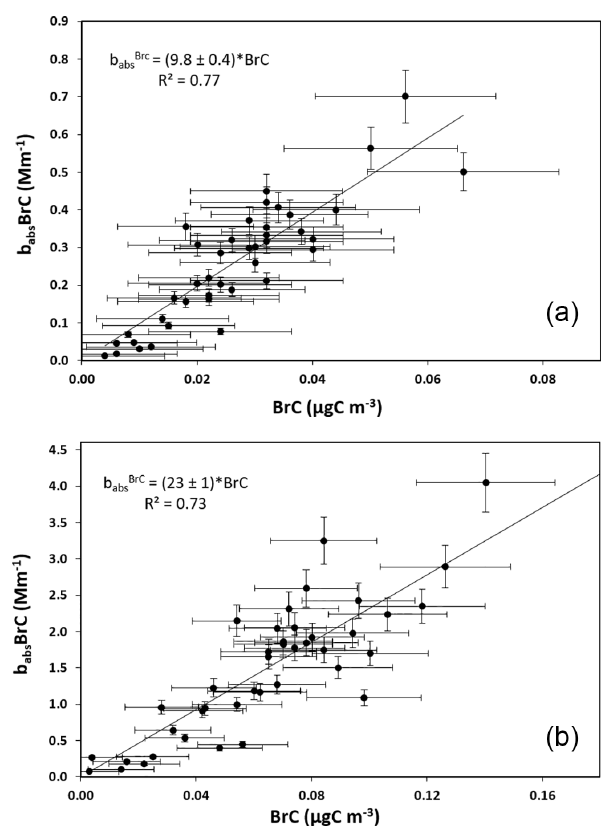
Figure 7. Comparison between the aerosol absorption coefficient apportioned to brown carbon vs. the resulting operative BrC con- centration values at λ = 635 (a) and at λ = 405nm (b)